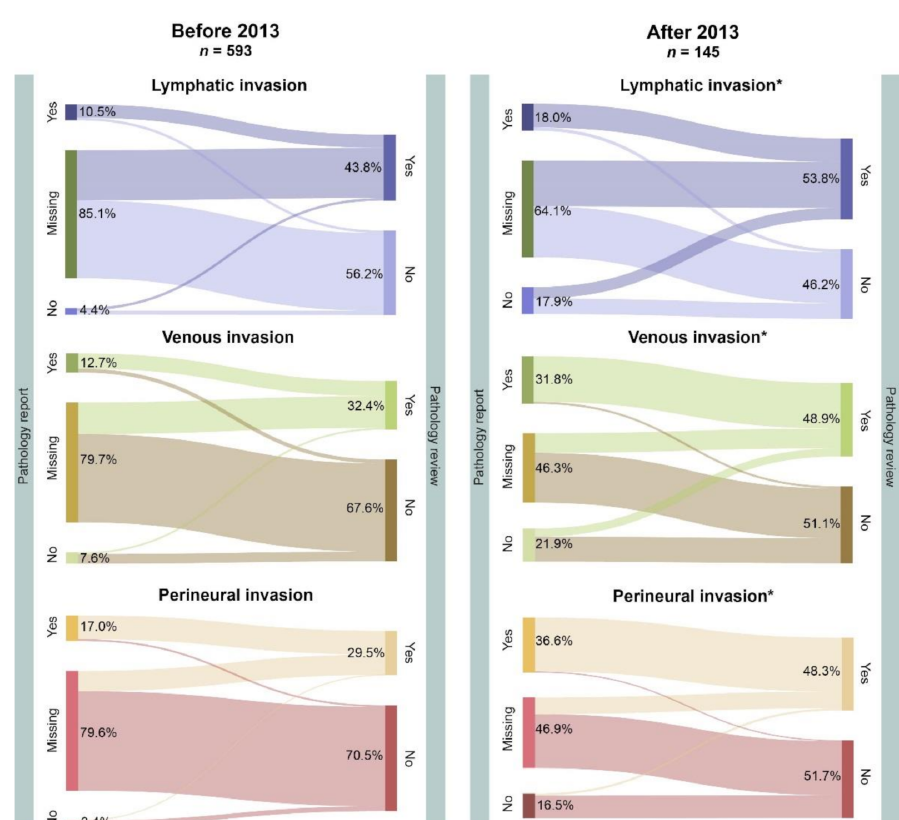
Figure 1. Comparison of pathology reports with pathology review before and after the update of the Dutch consensus guideline in 2013. For 738/849 cases, histopathological characteristics were reviewed by a pathology team, and results were compared with those from the report. In a large proportion of cases, data were missing from the original pathology report. A significant increase in concordance (report and review both “Yes” or both “No”) for all three types of invasion was observed after introduction of the consensus guideline in 2013, mainly due to a decrease in missing